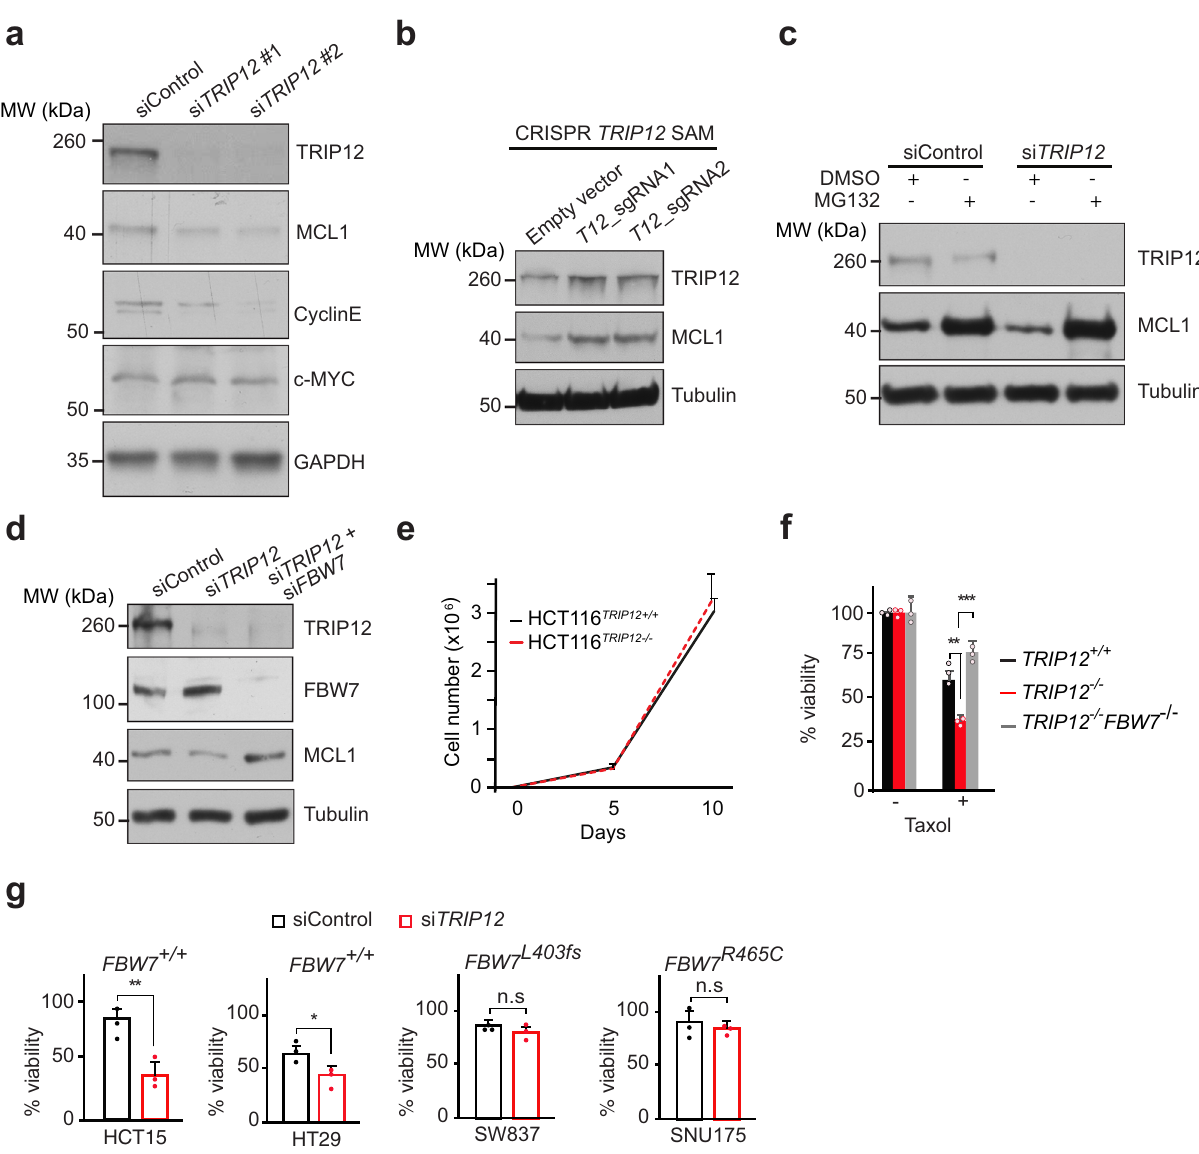
Fig. 3 TRIP12 regulates chemotherapy resistance via MCL1 and FBW7. a Western blots showing levels of the indicated FBW7 substrates in HEK293T cells treated with a control siRNA or two independent siRNAs targeting TRIP12 . b Western blots for TRIP12 and MCL1 in cells targeted with CRISPR/Cas9 SAM TRIP12 sgRNAs or an empty vector control. Tubulin used as a loading control. c Western blots for MCL1 from HEK293T cells treated with control and TRIP12 siRNA ± MG132. Tubulin used as a loading control. d Western blot for the indicated proteins in HEK293T cells treated with the indicated siRNAs. Blots in a – d are representative of at least three independent experiments. e Cell proliferation of HCT116 cells of indicated genotypes, as judged by cell counting on indicated days. Graph shows mean ± SD of three independent experiments. f Viability of HCT116 cells of the indicated genotypes as judged by CellTiter-Blue ® viability assay in the presence or absence of 100 nM Taxol and shown as % viability relative to the untreated control. Bar graphs represent Mean ± SD of three independent experiments, ** p = 0.004 and *** p = 0.0001. g Viability of colorectal cancer cell lines with the indicated genotypes, treated with 100 nM Taxol for 72 h as judged by CellTiter-Blue ® assay and shown as % viability relative to the control. Bar graphs represent mean ± SD of three independent experiments, ** p = 0.01 and * p = 0.04, n.s., not signi fi cant. p- values calculated by two-tailed type two Student ’ s t -test. See also Supplementary Fig. 3. Source data are provided as a Source Data fi